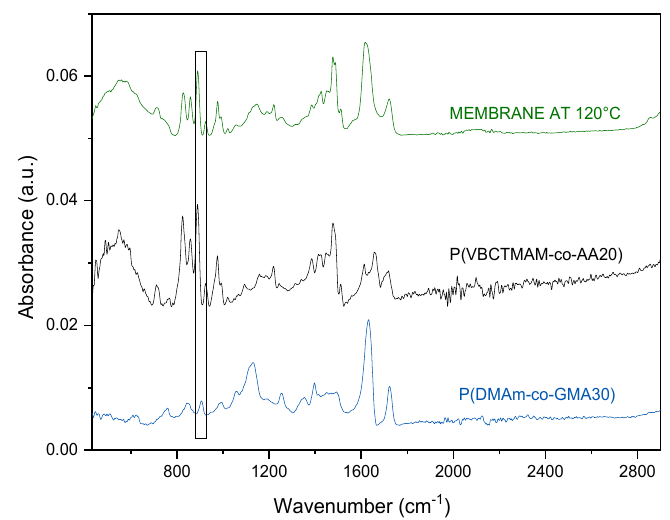
Figure 3. Attenuated Total Reflection Fourier Transform Infrared Spectroscopy (ATR-FTIR) spectra of the complementary copolymers and the crosslinked membrane P(VBCTMAM-co-AA20) / P(DMAm-co-GMA30) 80 / 20 w / w .